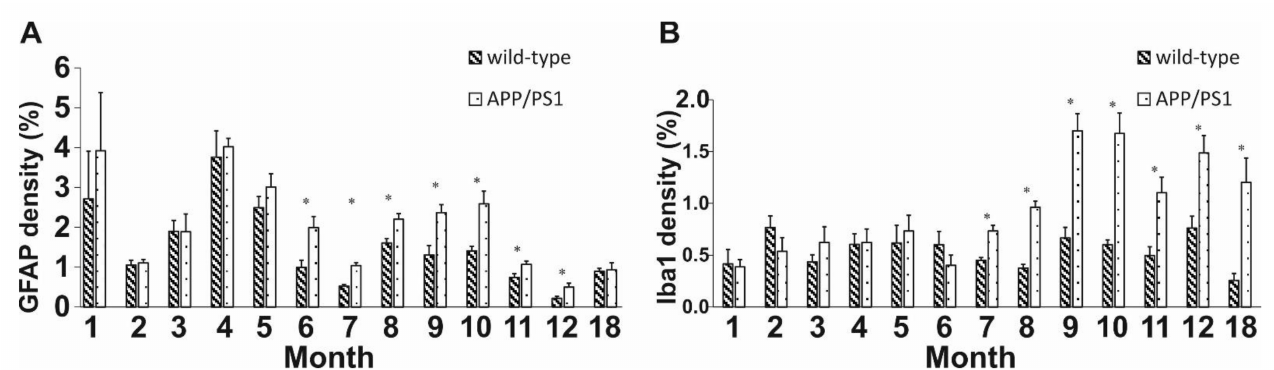
Figure 2. Quantitative results for GFAP and Iba1 stainings in DG. ( A ) Significant differences in the activation of reactive astrocytes were detected between 5- to 11-month-old APP/PS1 mice and age-matched controls. ( B ) Longitudinal alternations of microglial activation in DG. The densities of activated microglia of 7- to 18-month-old Tg mice were significantly higher compared to controls. Data represent mean ± SEM * indicates a significant between-group difference ( p <